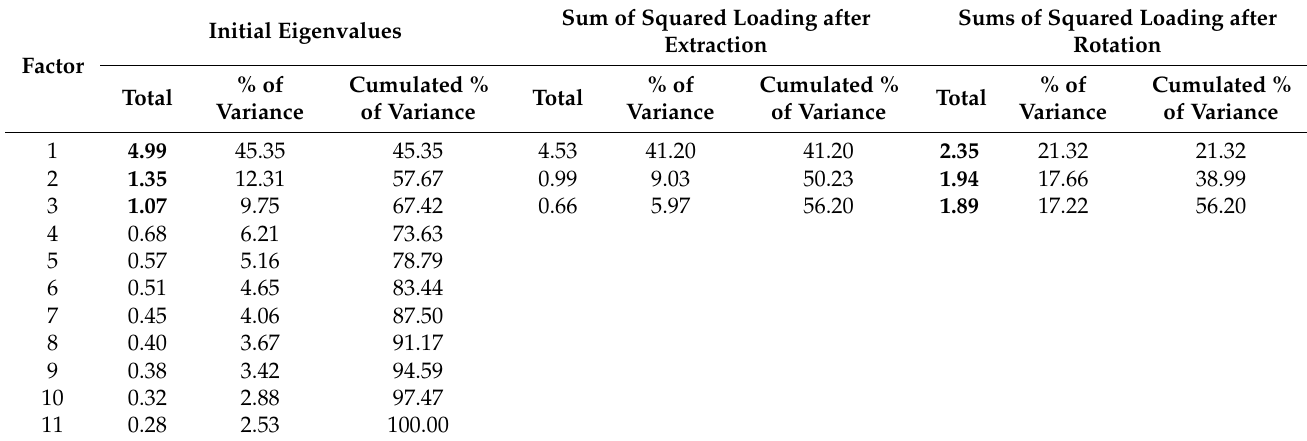
Table 3. Total variance explained by the three-factor latent structure of the scale.